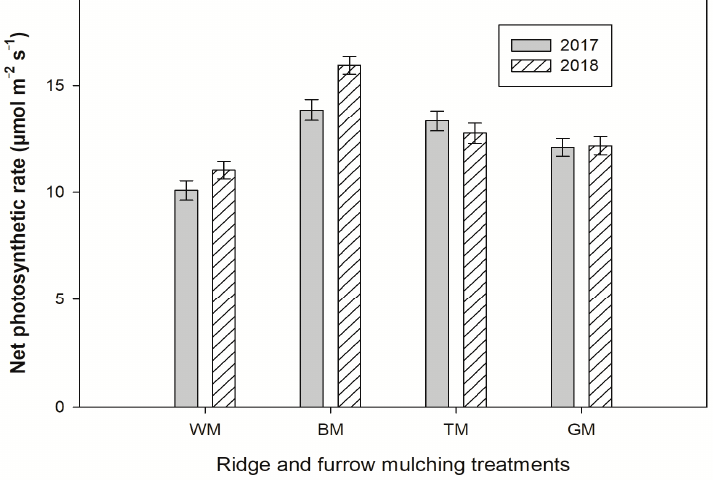
Figure 6. Influence of different ridge and furrow mulching treatments on net photosynthetic rate, of maize in 2017 and 2018. WM = Ridge-furrow without mulch, BM = Ridge-furrow covered with black plastic mulch, TM = Ridge-furrow covered with transparent plastic mulch, GM = Ridge-furrow covered with grass